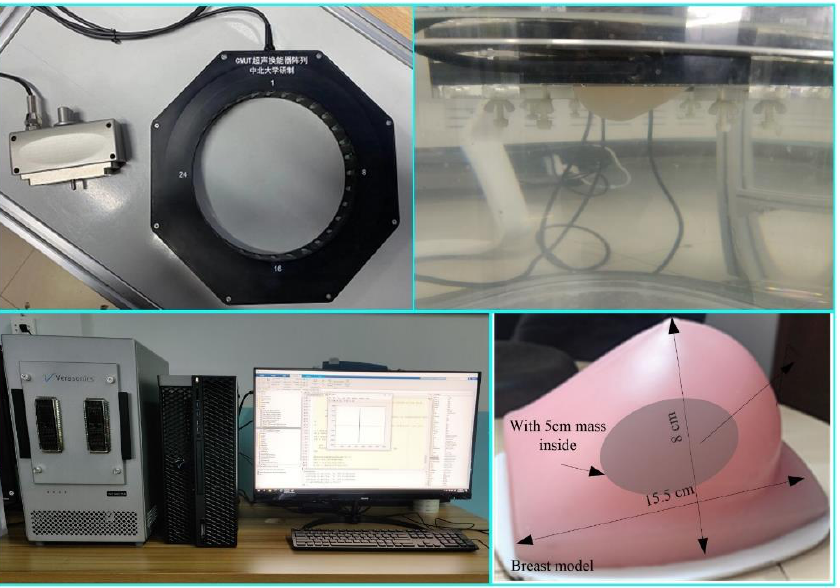
Figure 10. Experimental platform of breast ultrasound tomography system based on a CMUT ring array.